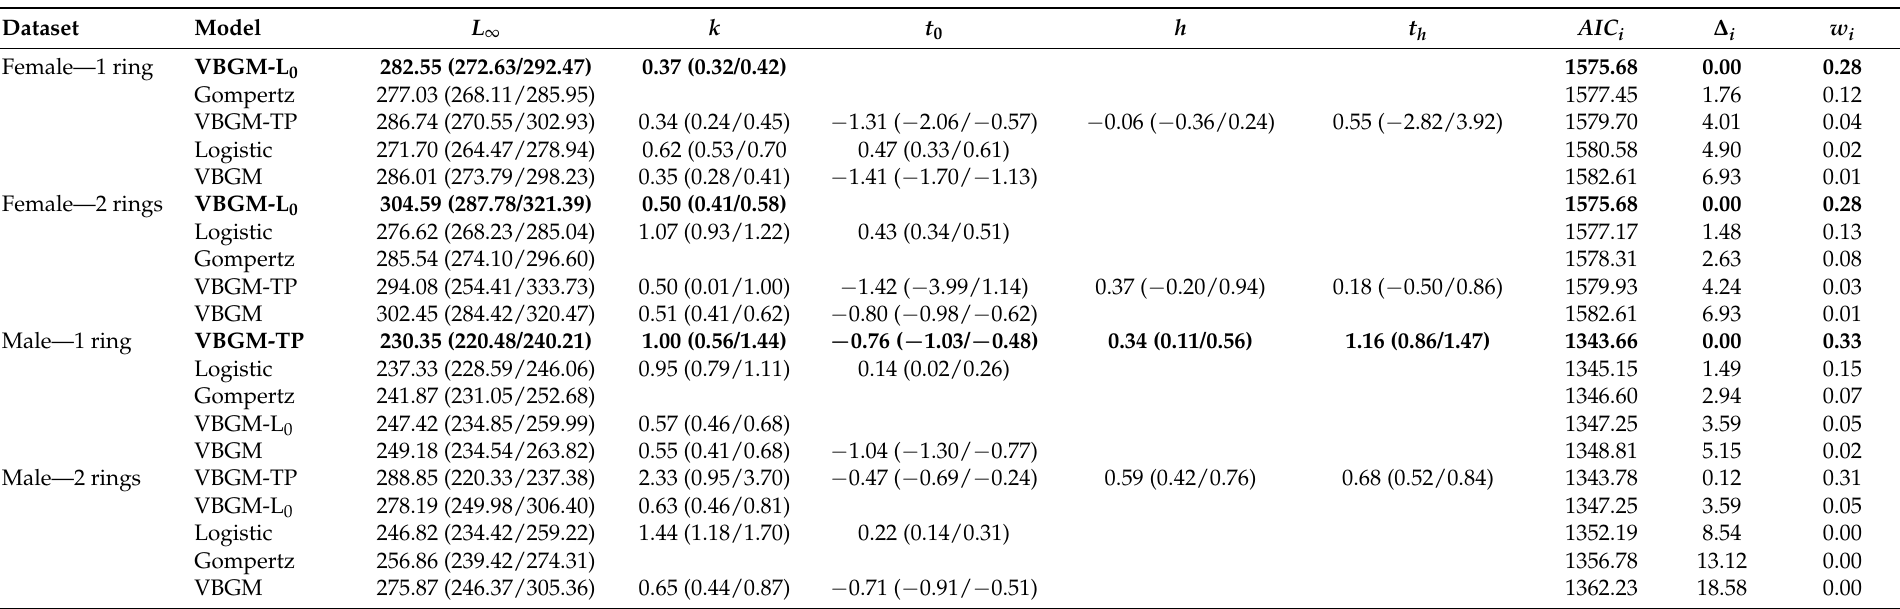
Table 2. Comparison between growth models for grouped sexes ranked based on the Akaike Information Criterion ( AIC ); ∆ i = Akaike difference; w i = Akaike’s weight. K = the number of model parameters. L ∞ = theoretical maximum length; k = growth constant; t 0 = theoretical age where the length of the fish is zero; L 0 = Estimated length at age 0. The values between parenthesis are the 95% confidence intervals of